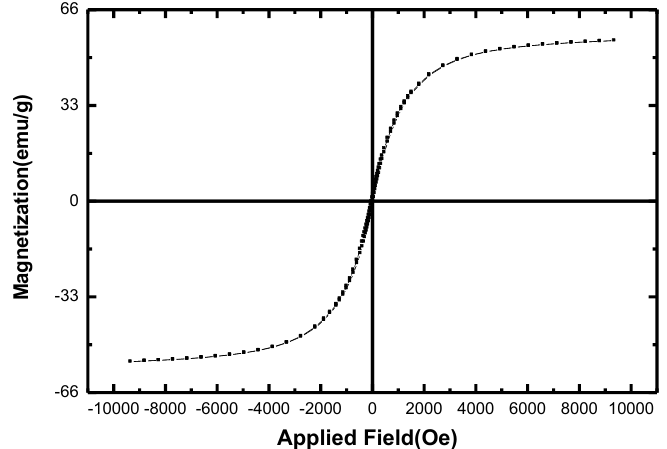
Fig. 9. Hysteresis loop of PS-Fe